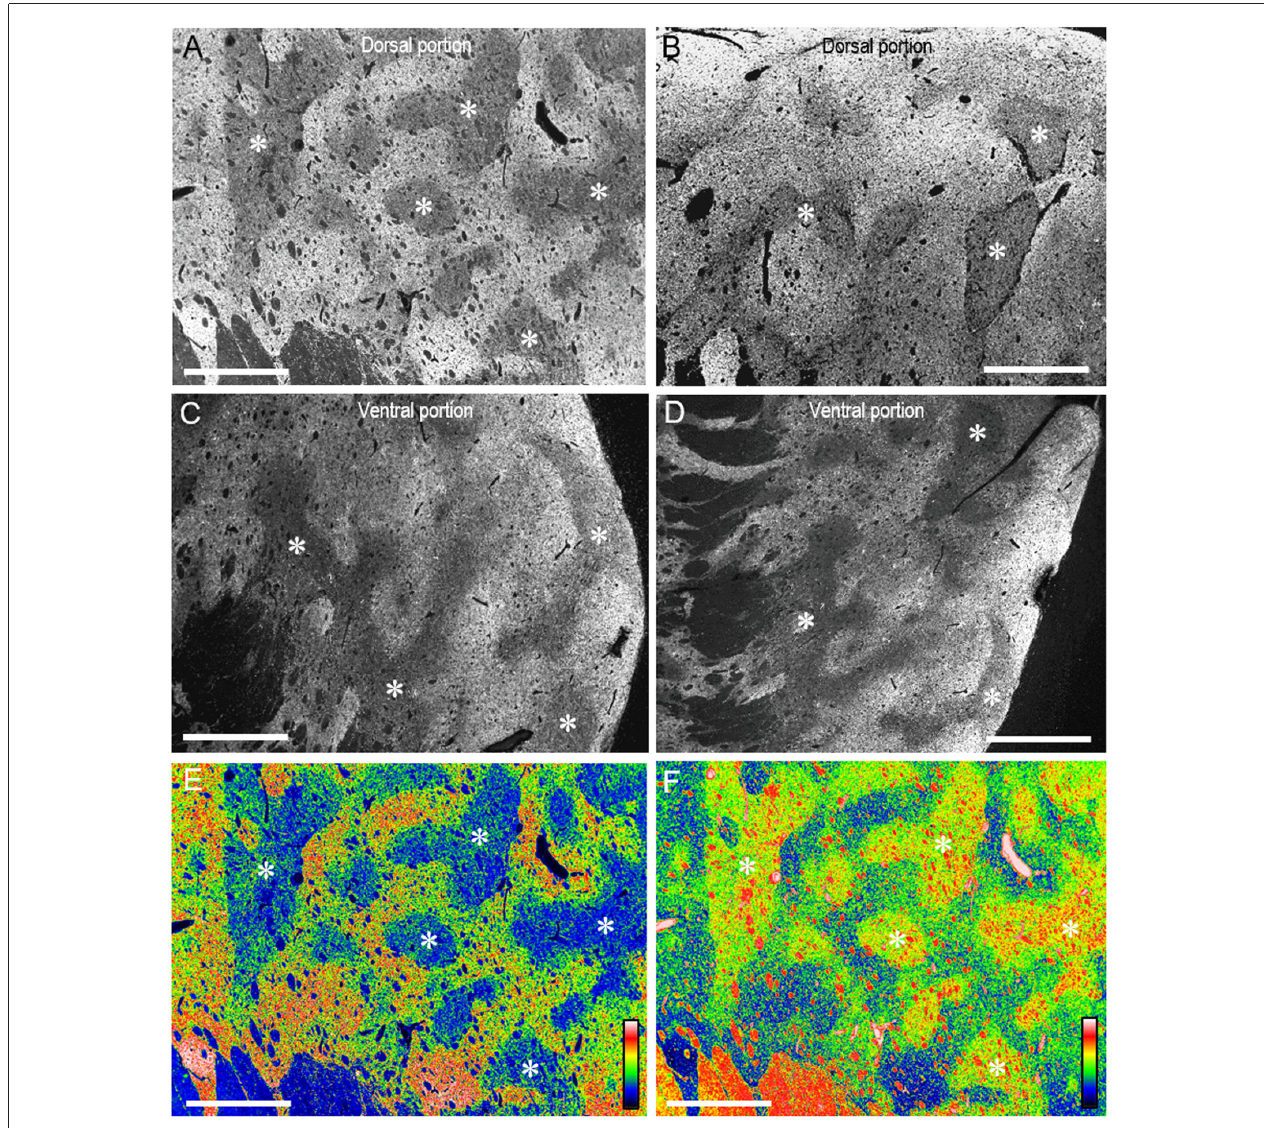
FIGURE 3 | Mosaic pattern of TH-immunostaining in the rostral putamen of the human brains. (A–D) Photomicrographs of the dark-field images taken from the dorsal (A,B) and ventral portions (C,D) of the rostral putamen stained with DAB for TH. Asterisks indicate examples of striatal subfields with sparse TH labeling. (E,F) Graded color-converted representations of dark-field (E) and bright-field (F) images of the striatal area stained with DAB for TH, which is shown in (A) . A standard pseudocolor scale from blue (lowest level) through green, yellow, red, and white (highest level) was used. Asterisks indicate examples of corresponding zones poor in TH-labeling. Scale bars: 2